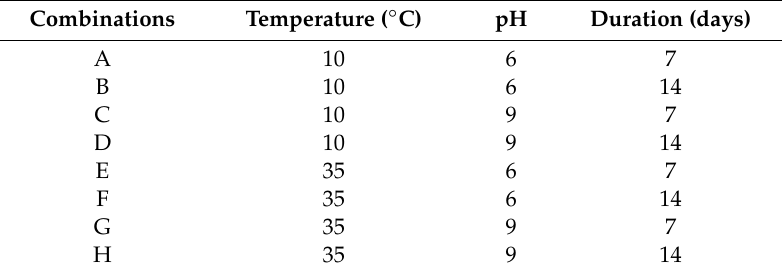
Table 1. Combinations of the design for the cocktail C. boidinii / B. pumilus .